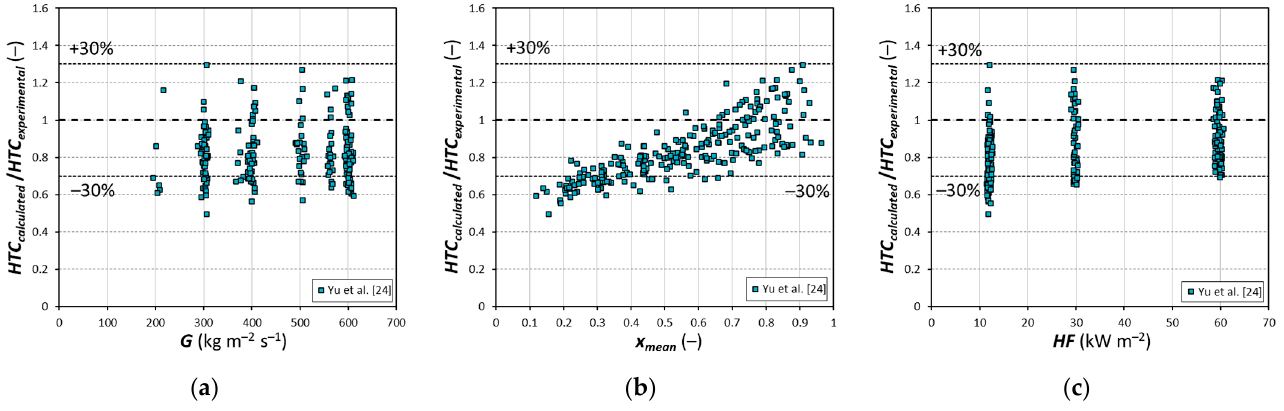
Figure 10. Ratio between calculated and experimental heat transfer coefficient versus: ( a ) mass velocity; ( b ) mean vapor quality; ( c ) heat flux. Model by Yu et al. [24].